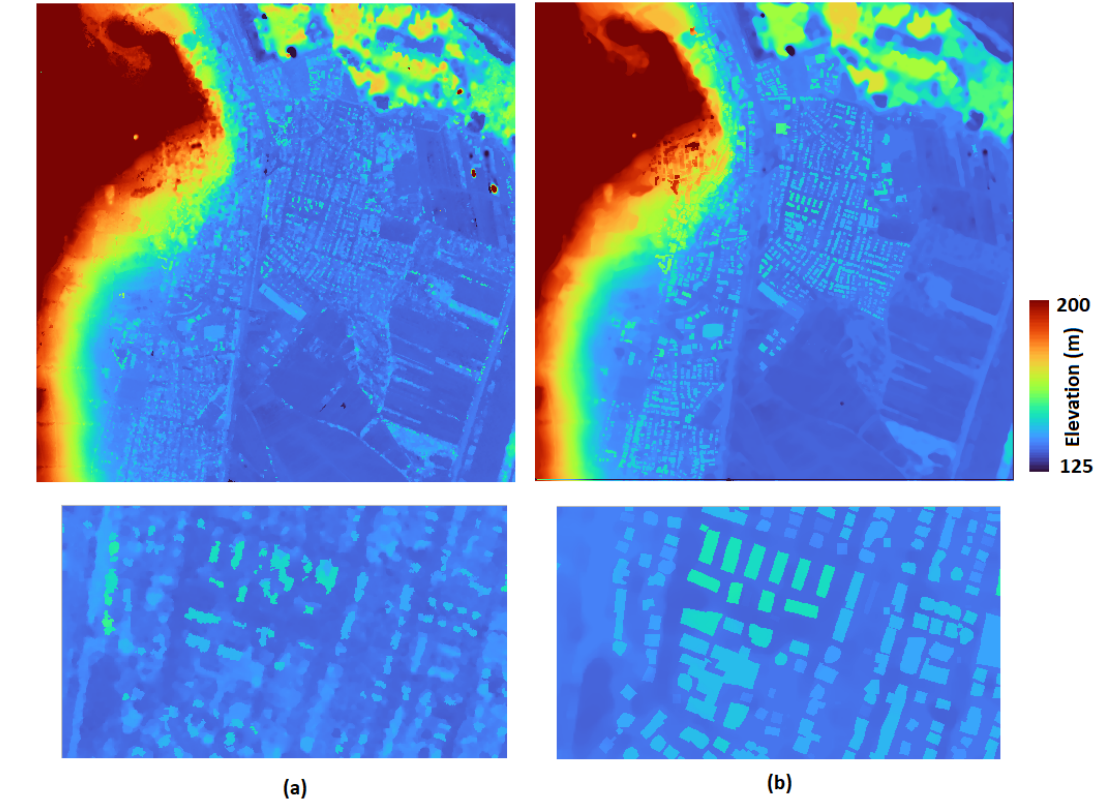
Figure 4. Comparison of the original generated DSM (a) and refined DSM (b).